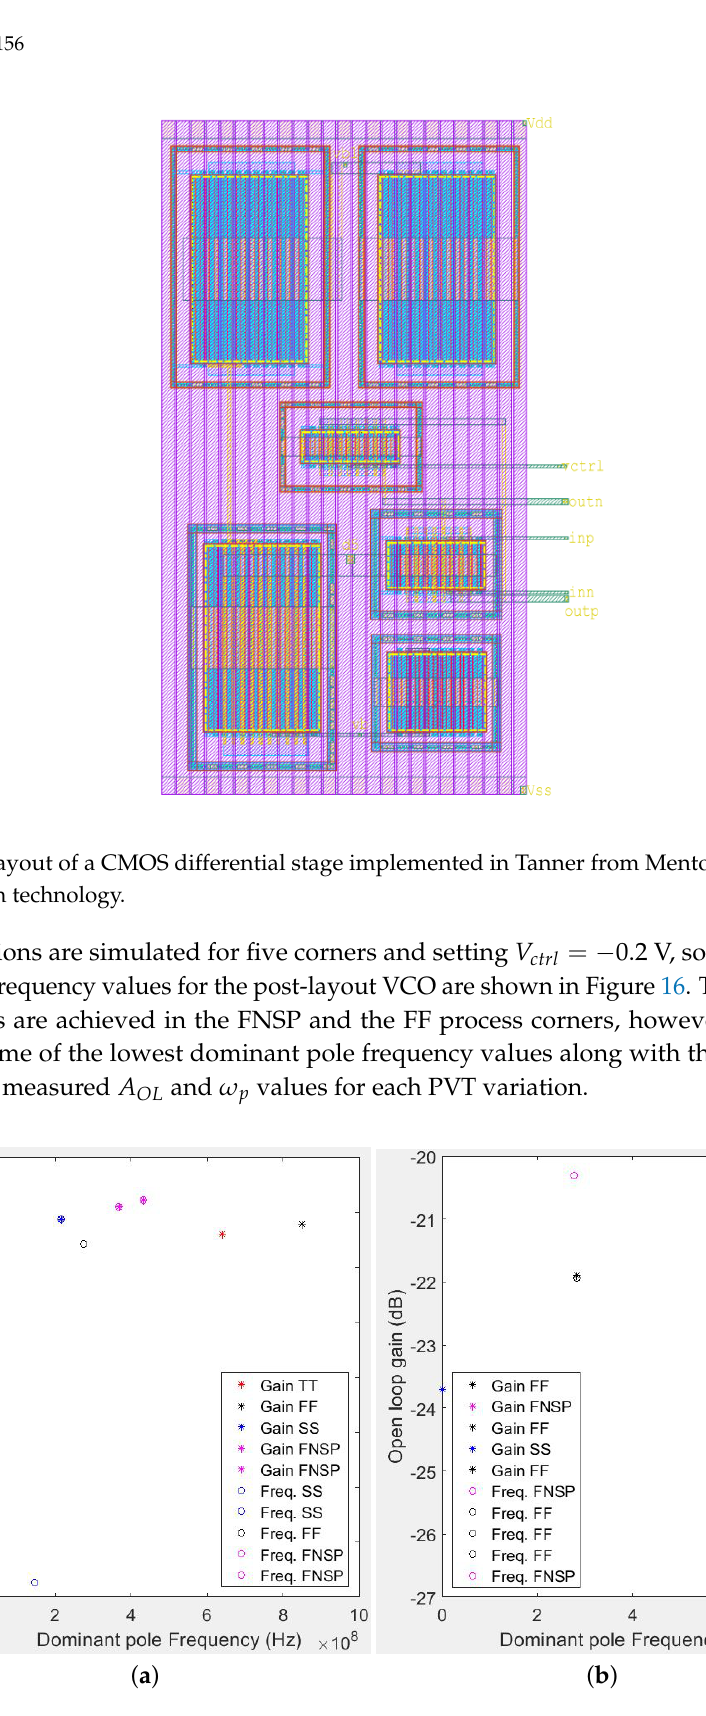
Figure 16. ( a ) Higher and ( b ) lower gains and dominant pole frequencies of the CMOS differential stage with active load under PVT variations and setting V ctrl = − 0.2